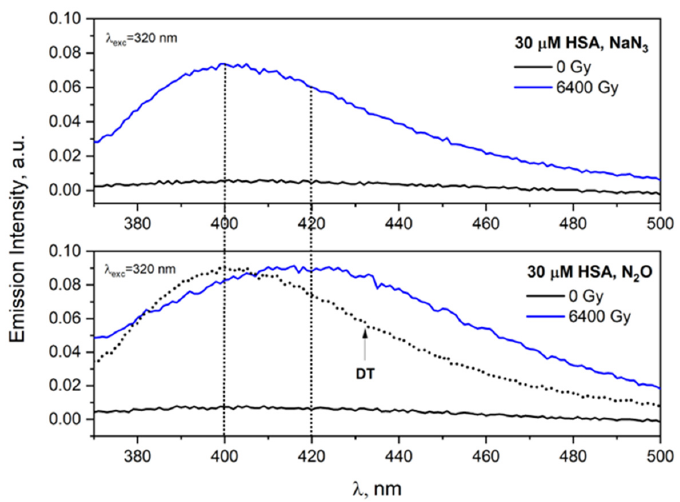
Figure 16. Emission spectra of N 2 O-saturated buffer solution of HSA (30 µM) containing NaN 3 (0.1 M), recorded before and after irradiation with a dose 6400 Gy. Emission spectra of N 2 O-saturated buffer solution of HSA (30 µM), recorded before and after irradiation with a dose 6400 Gy. The excitation wavelength was 320 nm. Measurements were made using a 0.2 cm quartz cuvette. The dashed lines shows λ max for DT (400 nm) and λ max for aggregates formed in the reaction of HSA with • OH radicals (429 nm).